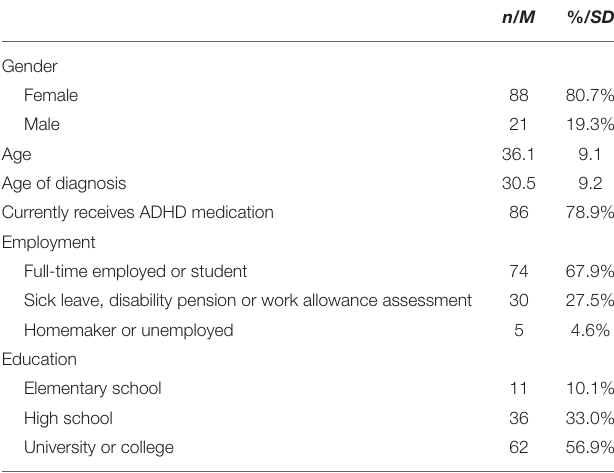
TABLE 1 | Demographic characteristics of participants, n =